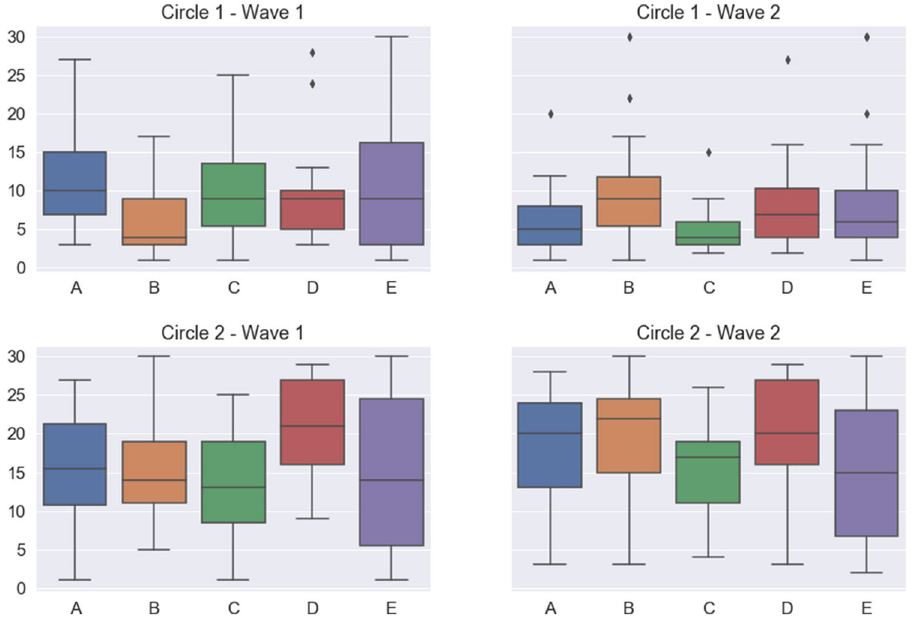
Figure 3. Boxplot of the answers about friendships and very good friendships restricted to the ego’s group. Top, numbers of students marked as “best friends” by students of each group (circle 1). Bottom, numbers of students marked as “friends” by students of each group (circle 2). Only relationships within the group are shown. Left, results from wave 1. Right, results from wave 2. Line represents the median, boxes the first and third quartiles, lines, the 95% confidence interval, and dots,